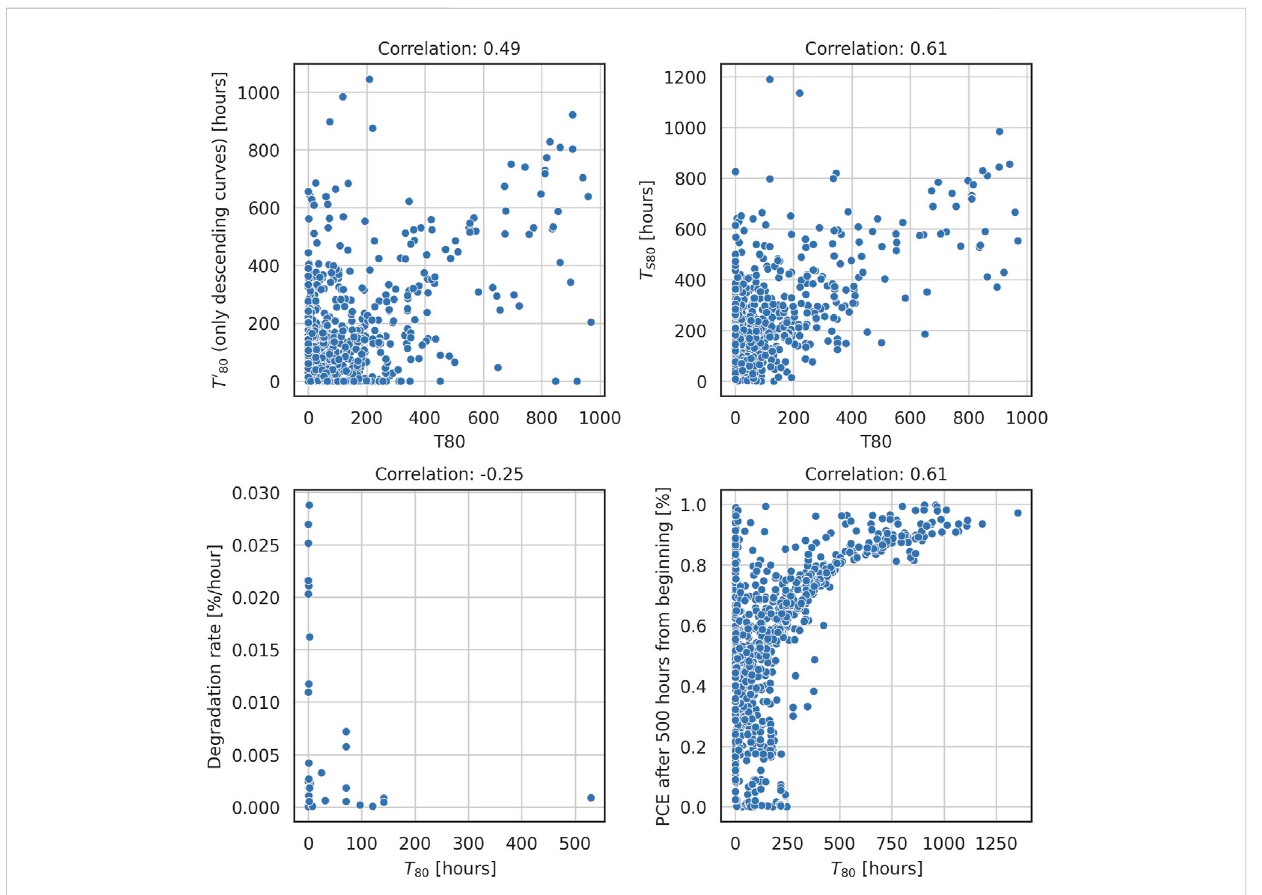
FIGURE 11 Scatter plot of T 80 against four other stability fi gures of merit. Above every plot, the corresponding Pearson correlation coef fi cient is